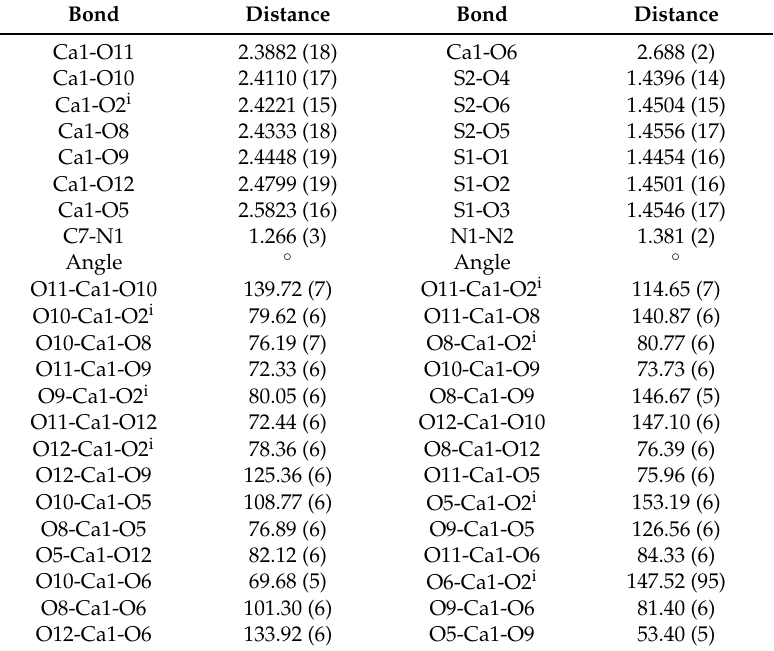
Table 1. Selected bond lengths (Å) and angles ( ◦ ) for 1 .